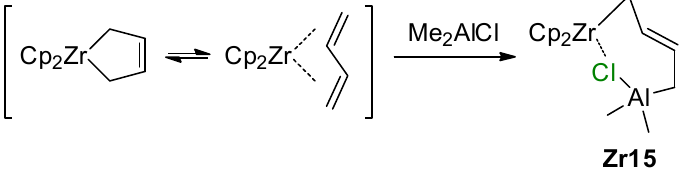
Scheme 20. Reaction of the Zr(IV) buta-1,3-diene complex with Me 2 AlCl [153]. Zr analogs of the Tebbe reagent Cp 2 Zr( µ -CHR)( µ -Cl)AlR (cid:48) 2 were obtained (a) by the reaction of Cp 2 Zr(Cl)CH=CHR with R (cid:48) 2 AlH or (b) by the reaction of Cp 2 ZrHCl with R (cid:48) 2 AlCH=CHR [154,155]. The molecular structure of one of these complexes